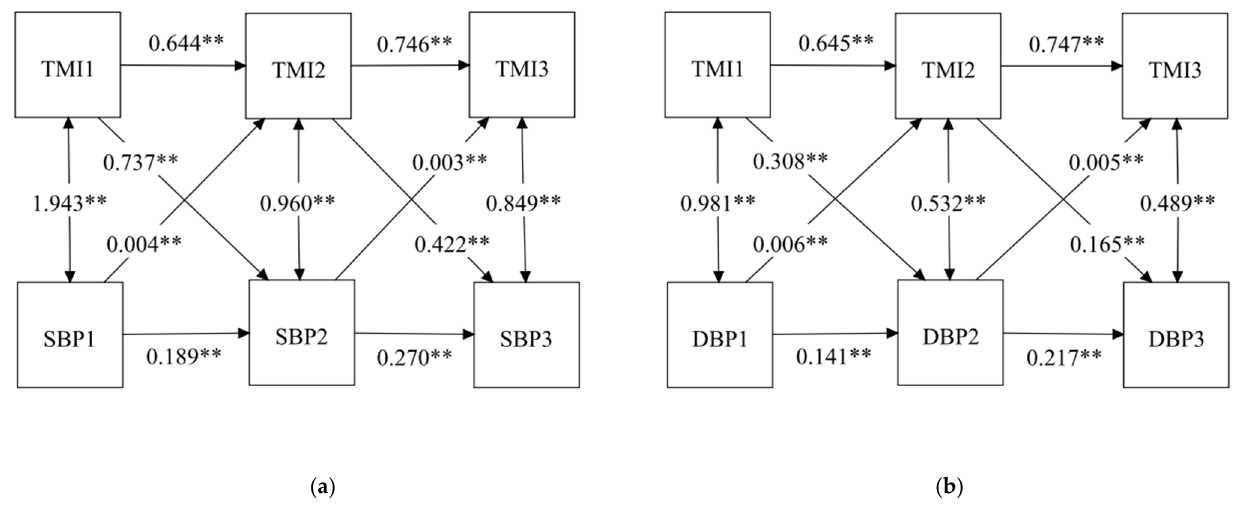
Figure 3. Cross-lagged model with TMI and BP among children at three time points: ( a ) cross-lagged model with TMI and SBP; ( b ) cross-lagged model with TMI and DBP; ** p < 0.001; TMI, tri-ponderal mass index; SBP, systolic blood pressure; DBP, diastolic blood pressure.